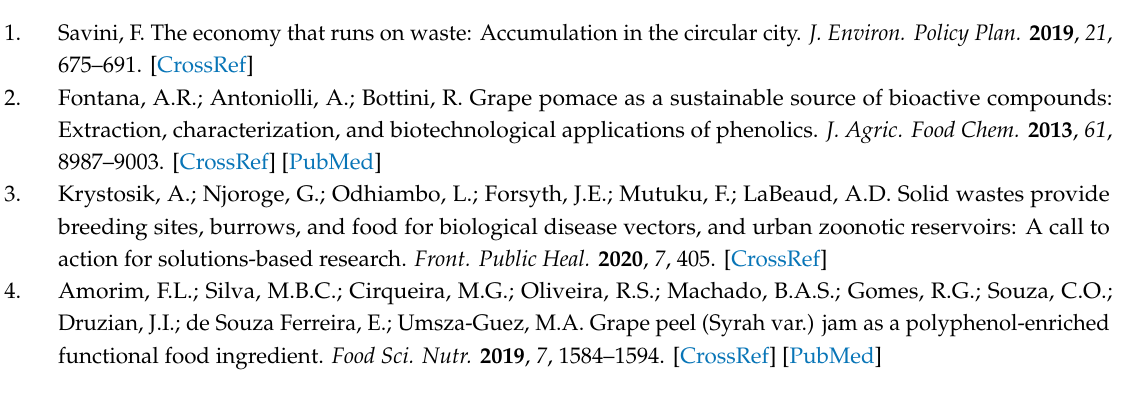
Supplementary Materials: The Supplementary Materials are available online. Figure S1, Chromatograms of the phenolic compounds and their respective retention time (RT), equation and regression coe ffi cient (R2). To identify and quantify the compounds were used DAD in the wavelengths 280 (a), 320 (b), 360 (c), 520 nm (d), and fluorescence at 280 nm excitation and 320 nm emission